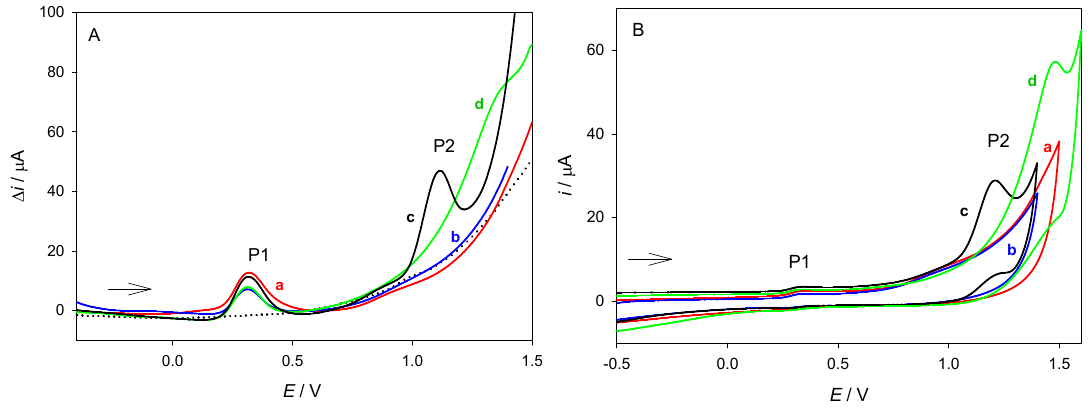
Figure 1. ( A ) Square-wave and ( B ) cyclic voltammograms of 0.1 mmol/L 13a in 0.5 mol/L NaClO 4 at pH 3 (a), 7 (b), 9 (c) and 10 (d). ( A ) E sw = 50 mV, E s = 2 mV, f = 100 Hz. Dotted line represents SW voltammogram of the supporting electrolyte; ( B ) v = 100 mV s −1 , E s = 2 mV. Arrows indicate the scan direction.